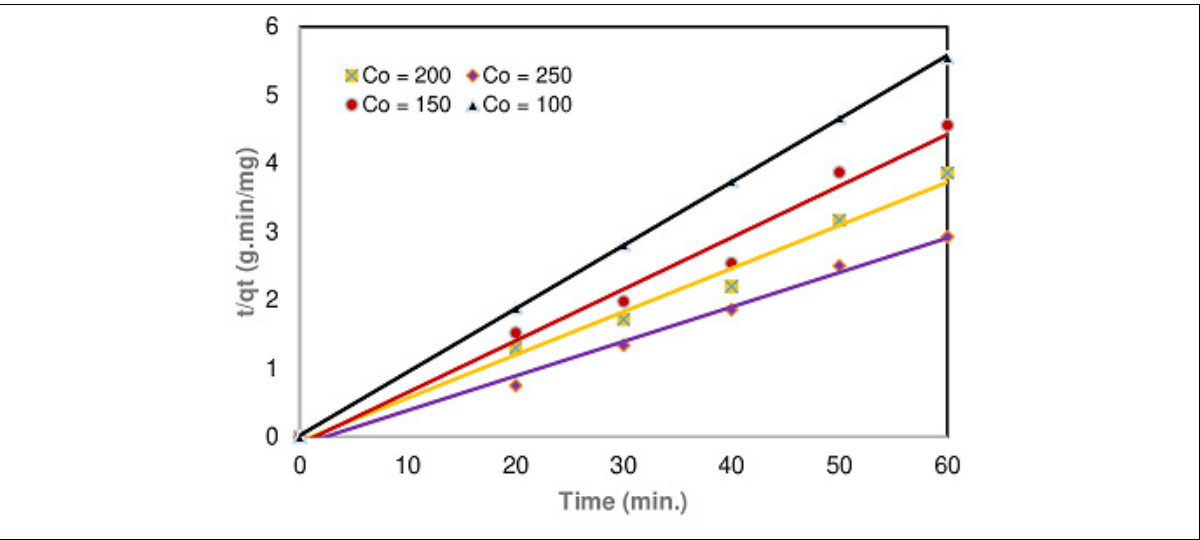
Figure 6: Pseudo-first-order model fitted to batch equilibrium data for edible oil wastewater photodegradation.